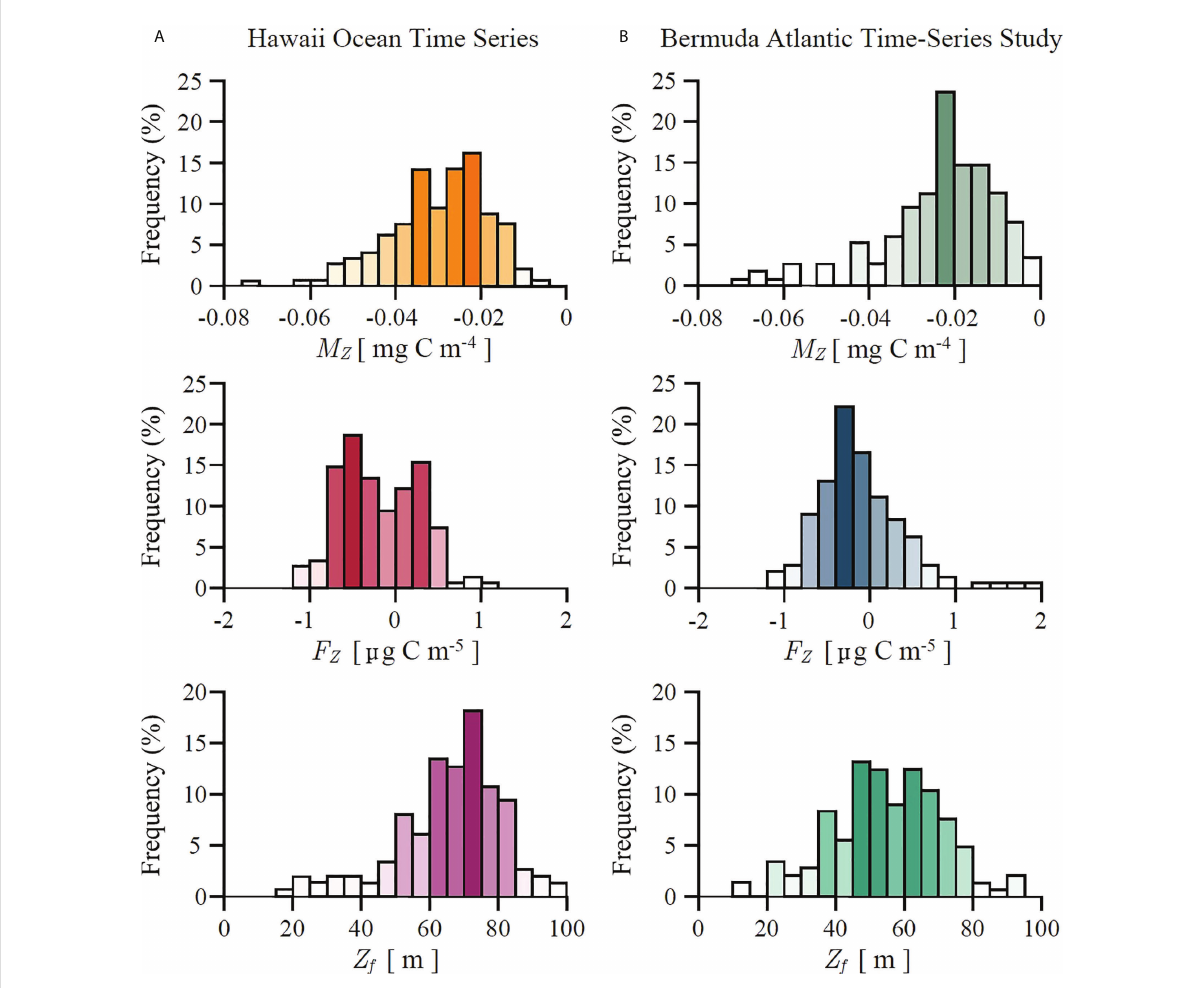
FIGURE 5 Histograms of marginal mixed-layer production M Z , mixed-layer production fragility F Z and fragility depth Z f, as de fi ned in (24), (27) and (31) respectively, estimated from in situ data at: (A) Hawaii Ocean Time Series and (B) Bermuda Atlantic Time-Series Study. At both stations marginal production M Z is negative. Positive F Z corresponds to antifragile states for which variability in mixed-layer depth acts favourably on biomass and production. Negative F Z corresponds to fragile states for which variability in mixed-layer depth acts unfavourably on biomass and production. When the mixed-layer is shallower than Z f the system is in a fragile state. When it is deeper than Z f the system is in an antifragile